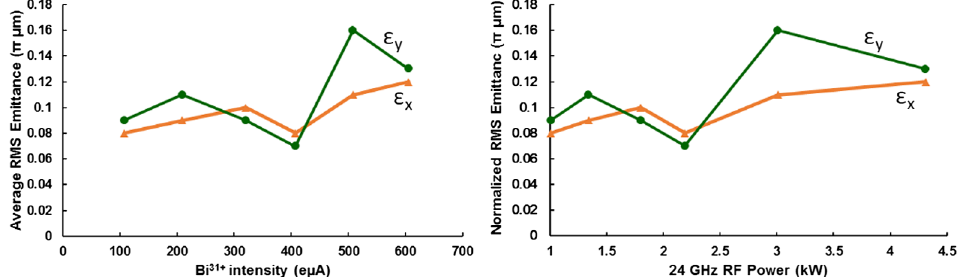
FIG. 24. Dependences of normalized rms emittance on the beam 209 Bi 31 þ intensity and the 24 GHz microwave power at SECRAL.